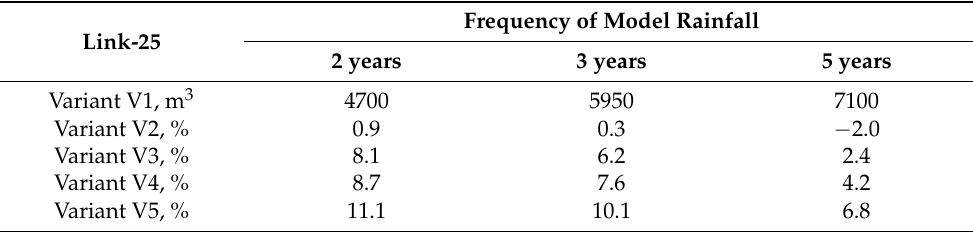
Table 6. Reduction of runoff volume as compared to the base variant—Link-25 calculation segment.